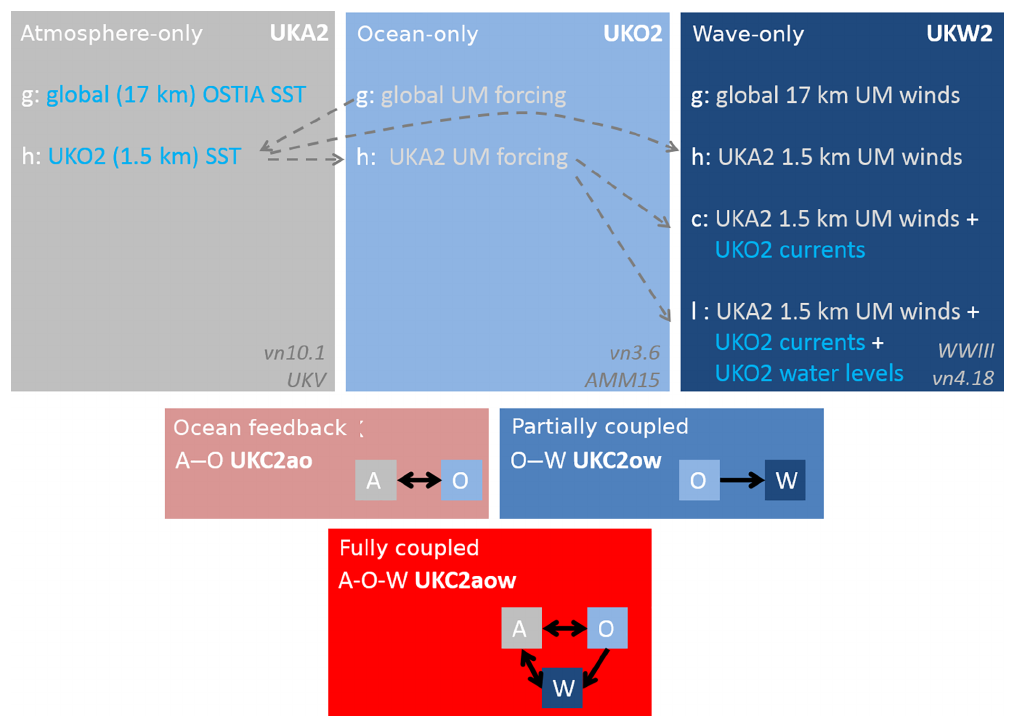
Figure 5. Summary of UKC2 system case study evaluation configurations in component-only and coupled mode. Arrows highlight the dependencies between forcing used in the control